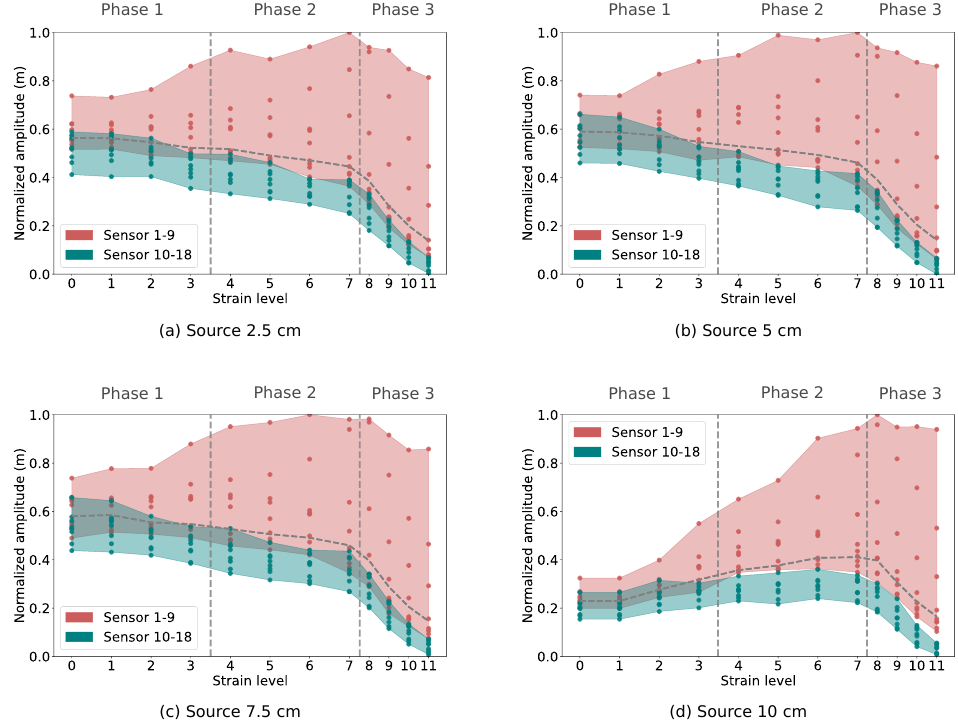
Figure 7. ( a – d ) Scatter plots of the average of the averaged envelope of the Coda signals as a function of increasing strain levels (from level 0 to 11) obtained for four locations of the sender (see Table 2 for the exact values of the strains corresponding to the strain levels). In each plot, three phases of damage (Phase 1: Elastic deformation and microcrack initiation, Phase 2: pre-peak microcracking and Phase 3: Microcrack coalescence and post-peak crack localization) of the concrete specimen are